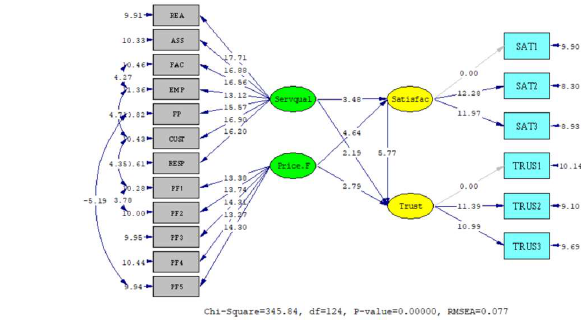
Fig. 3. Final Model (T-Value)